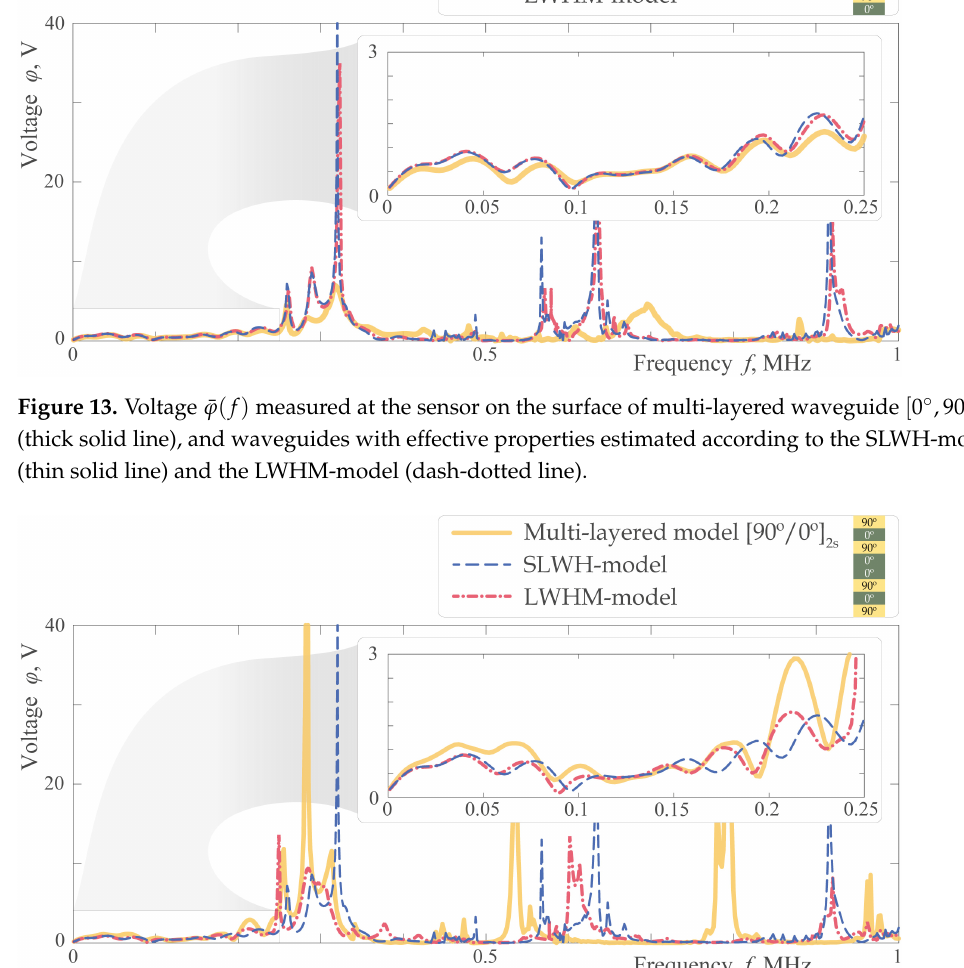
Figure 14. Voltage ¯ ϕ ( f ) measured at the sensor on the surface of multi-layered waveguide [ 90 ◦ ,0 ◦ ] 2s (thick solid line), and waveguides with effective properties estimated according to the SLWH-model (thin solid line) and the LWHM-model (dash-dotted